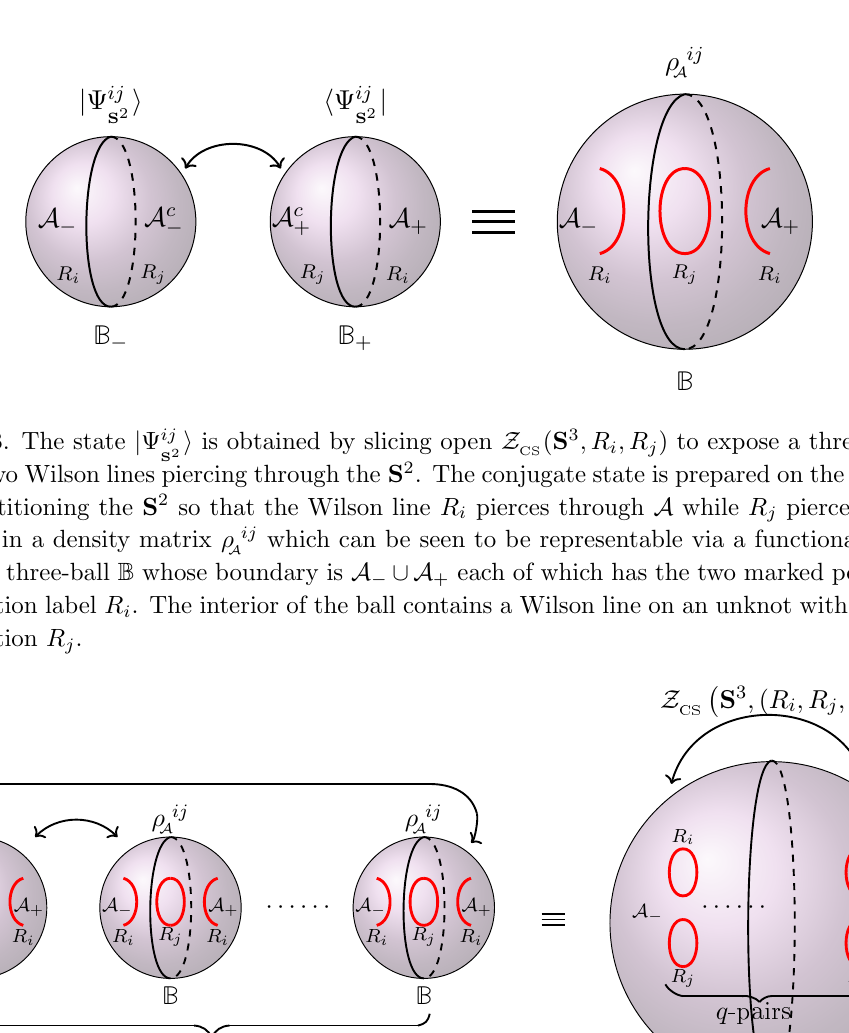
Figure 19 . The replica computation for the density matrix (cid:26) balls B whose boundary is the union of A (cid:6) for the chosen bipartition. As a result one ends up with a functional integral which computes Z S 3 partition function with q -pairs of Wilson lines along unknots in representations R i and R j ,